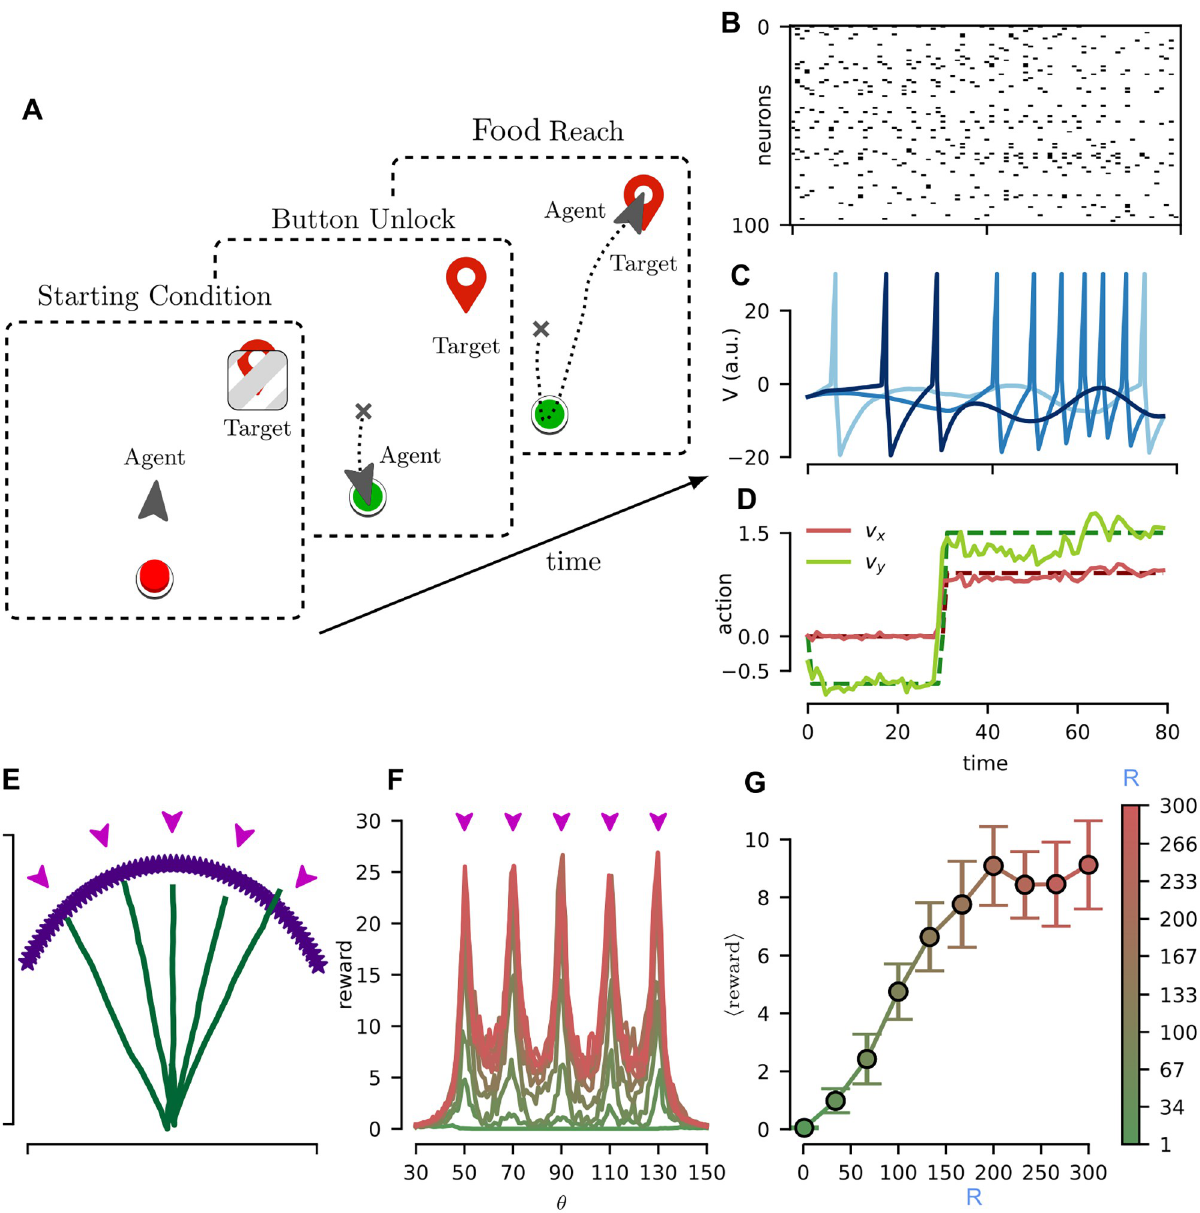
Fig 4. Button-and-food task. ( A ) Sketch of the task. An agent starts at the center of the environment domain (left) and is asked to reach a target. The target is initially “locked”. The agent must unlock the target by pushing a button (middle) placed behind and then reach for the target (right). ( B ). Rasterplot of the activity of a random sample of 100 neurons across 80 time unit of a task episode. ( C ). Temporal dynamics of the membrane potential of three example units. ( D ) Target v x , y (dashed lines), the velocity direction in the bi-dimensional plane, and the one reproduced by the network after the behavioral cloning (solid lines). ( E ) Example trajectories produced by a trained agent for different target locations. Purple arrows depict the positions of the food for the observed expert behaviors. ( F ) Final reward obtained by a trained agent as a function of the target position (measured by the angle θ with a fixed radius of r = 0.7 as measured from the agent starting position). Individual lines are average values over 10 repetitions. Color codes for different ranks in the error propagation matrix. ( G ) Average over all the target positions of final reward as a function of the rank. Error bars represent the standard deviation of the